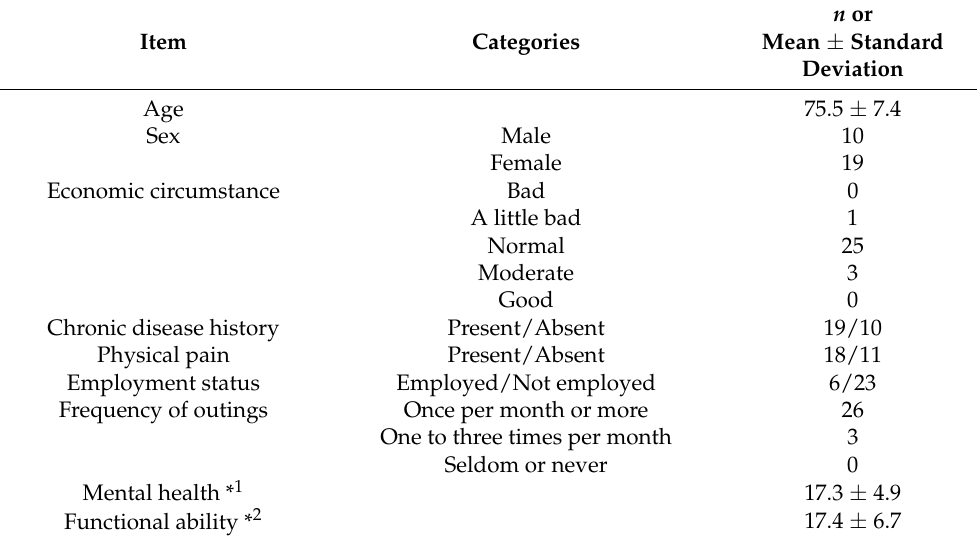
Table 1. Participants’ characteristics.